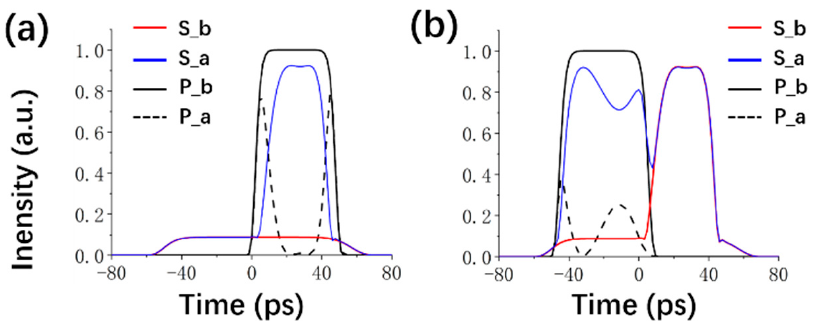
Figure 3. The evolution of the signal and pumps in the temporal domain (S: signal, P: pump, b: before amplification, a: after amplification, e.g., S_b means signal before amplification) for double-crystal scenario ( a ) OPA1 and ( b ) OPA2. Table 1. The parameters of OPAs for double-crystal scenario and triple-crystal scenario.